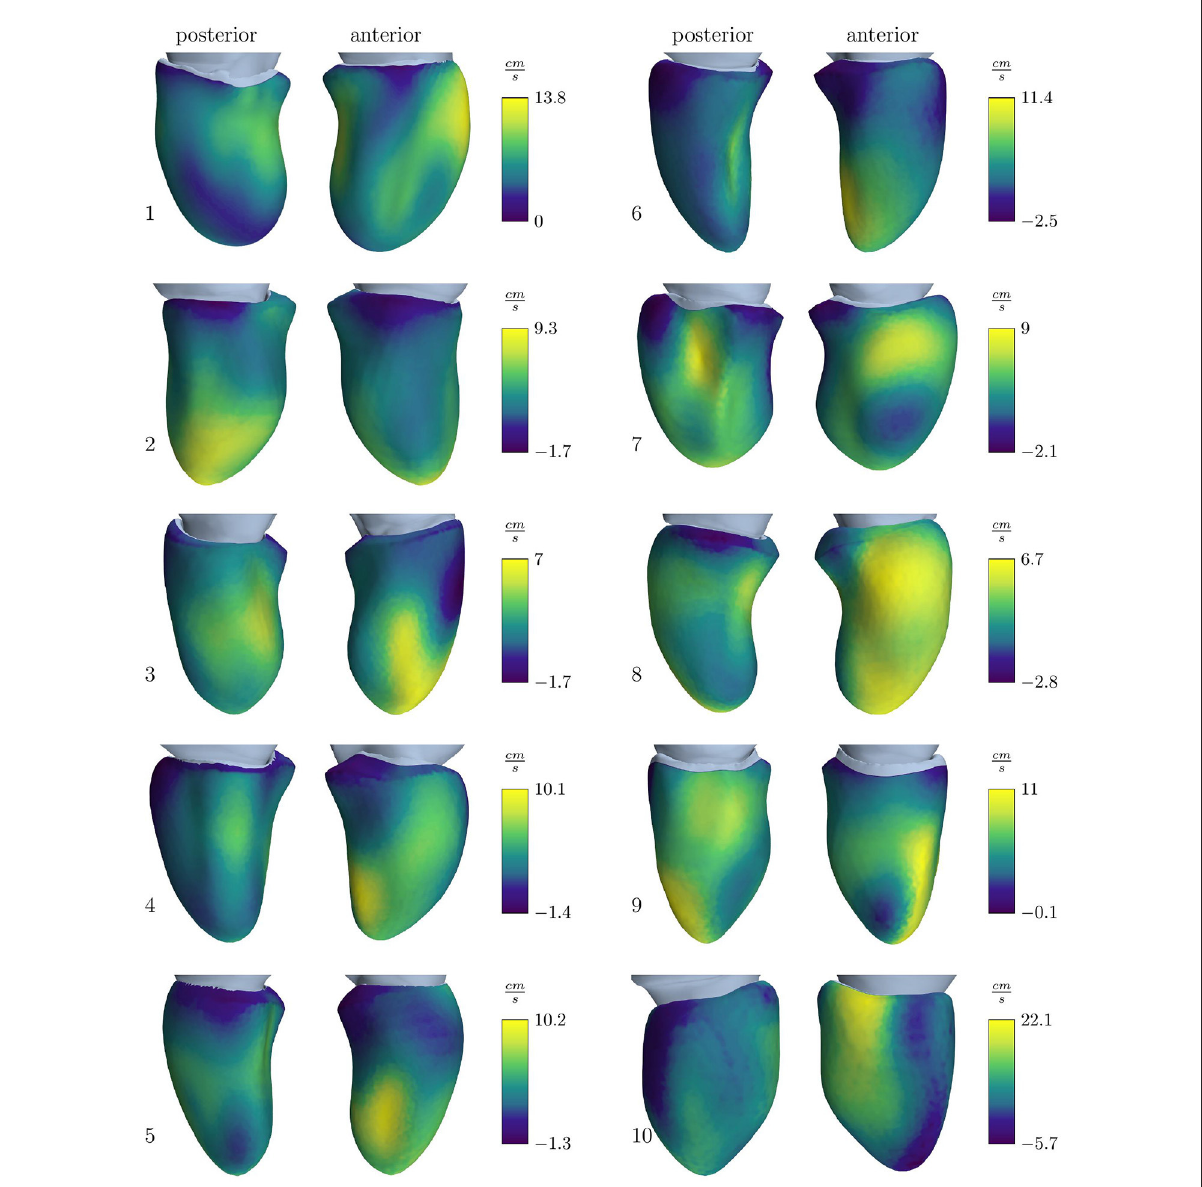
FIGURE4 Velocity outlet boundary condition for the simulation cohort resulting to obtain the E-wave flow measured by volumetric analysis. Positive values stand for an outward directed flow representing wall movement away from the center, while negative values represent a movement toward the